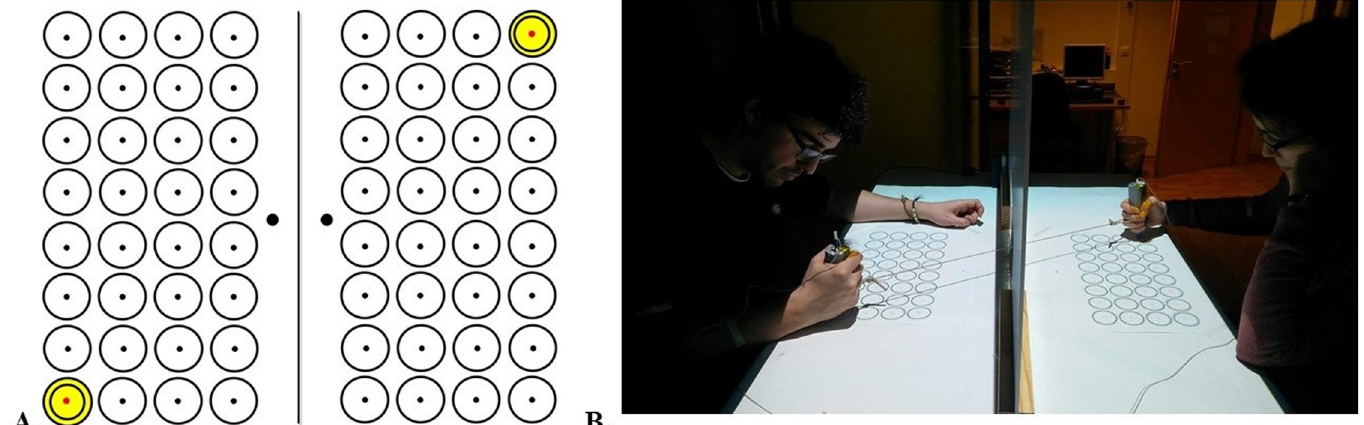
Fig 1. Experimental apparatus and stimuli. (A) 4 x 8 arrays of possible target locations for the two actors; targets were projected as yellow concentric circles with a red centre. The diameter of each of the outer circle was 4.5 cm and that of the red center was 0.5cm. A black dot above each target array marked the starting position for the movement. Two simultaneously cued target locations for the confederate and the participant constitute a configuration . (B) Figure shows actors haptically coupled by an elastic band, while performing in the joint action phase in which each actor had to hit the red center of their own target circles, synchronising with their partner, using the handles provided to them. The individuals from the photograph has given written informed consent (as outlined in PLOS consent form) to publish this